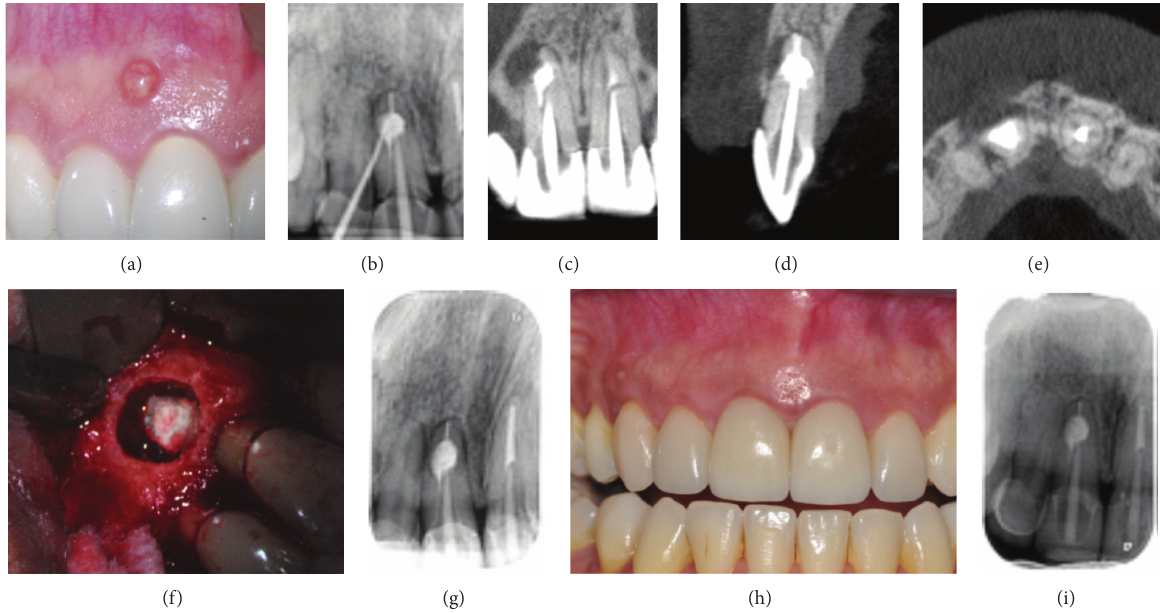
Figure 5: Surgical management of an internal resorption through a retrofilling with MTA (tooth 11). (a) Preoperative view: presence of a sinus tract. (b) Preoperative intraoral radiography with a gutta percha point in the sinus tract, leading to the source of infection [11]. (c), (d), and (e) Sagittal, coronal, and axial CBCT cross-sections. (f) Surgical cleaning of the root resorptive lesion and retrofilling with MTA. (g) Postoperative periapical X-ray of the root treatment: the filling is dense without overfilling. (h) One year followup: the clinical view confirms the sinus tract disappearance and the healthy appearance of the gums. (i) Periapical X-ray corroborates the periodontal regeneration in close contact with MTA